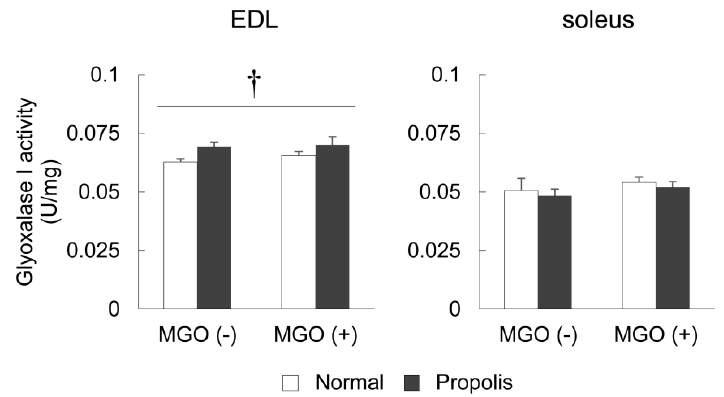
Figure 3. The activity of glyoxalase 1 in skeletal muscles. EDL and soleus muscles were dissected from mice treated with or without Brazilian propolis (0.1%)-containing diet or MGO (0.1%)-containing drinking water for 20 weeks. Values are means ± SE; n = 5–6/group. †, significant main effect between diets (normal and propolis).